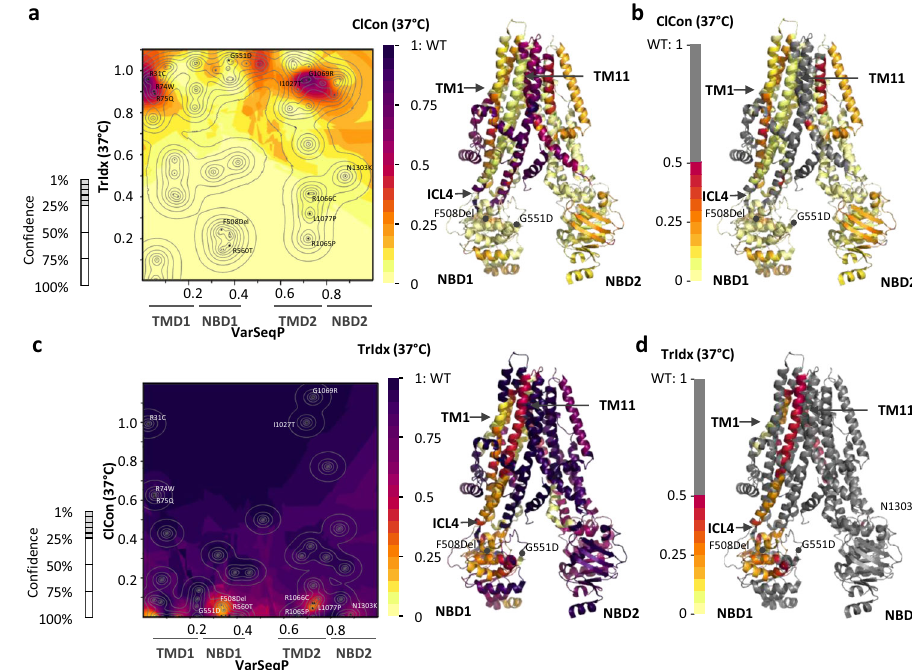
Fig. 2 VSP-based ClCon- and TrIdx-phenotype landscapes at 37 °C. a (Left panel) ClCon- phenotype landscape using the VSP-predicted values for TrIdx (band C/total (B + C) ratio; y -axis) and ClCon ( z -axis) in response to sequence position (VarSeqP, x -axis). ClCon-phenotype landscape overlaid with 5, 10, 25, 50, and 75% uncertainty contour intervals (left panel, gray lines). Uncertainty values <25% are of high con fi dence and cover 95% of known and predicted residues. (Right panel) ClCon functional-structure (PDB: 5UAK) mapped using the highest con fi dence values for each residue found in the ClCon-phenotype landscape (left panel). b ‘ Grayout ’ of panel A ClCon functional-structure showing only residues with <50% of WT measured value. The grayout structure highlights in a color gradient the known and predicted unknown residue functions that are likely to contribute to disease due to reduced ClCon. c (Left panel) traf fi cking index (TrIdx)-phenotype landscape using the VSP-predicted values for ClCon ( y -axis) and TrIdx ( z -axis) in response to sequence position (VarSeqP, x -axis) overlaid with the con fi dence contour intervals. (Right panel) TrIdx-phenotype landscape de fi ned functional structure (PDB: 5UAK). d ‘ Grayout ’ of panel C TrIdx functional structure showing only residues with <50% of WT measured